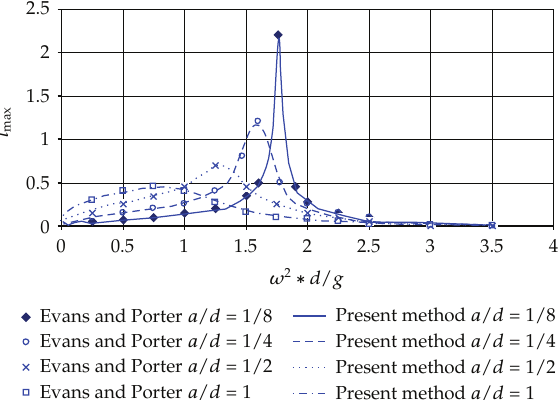
Figure 10: The maximum capture width against ω 2 · d/g in various geometries of a restrained OWC device.